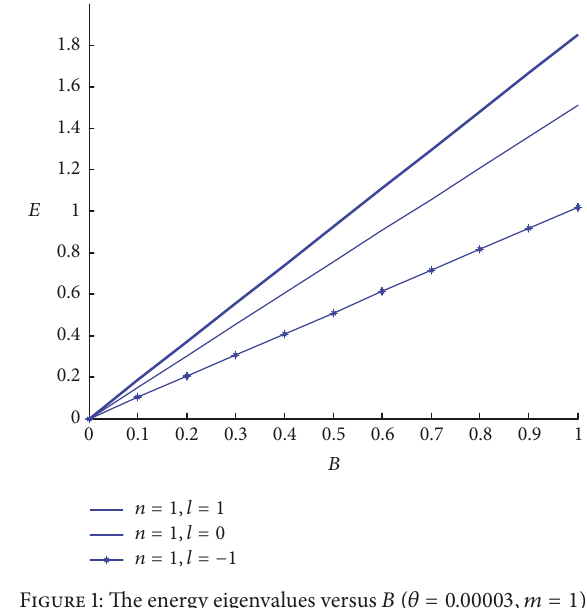
Figure 1: The energy eigenvalues versus 𝐵 ( 𝜃 = 0.00003 , 𝑚 = 1 ).